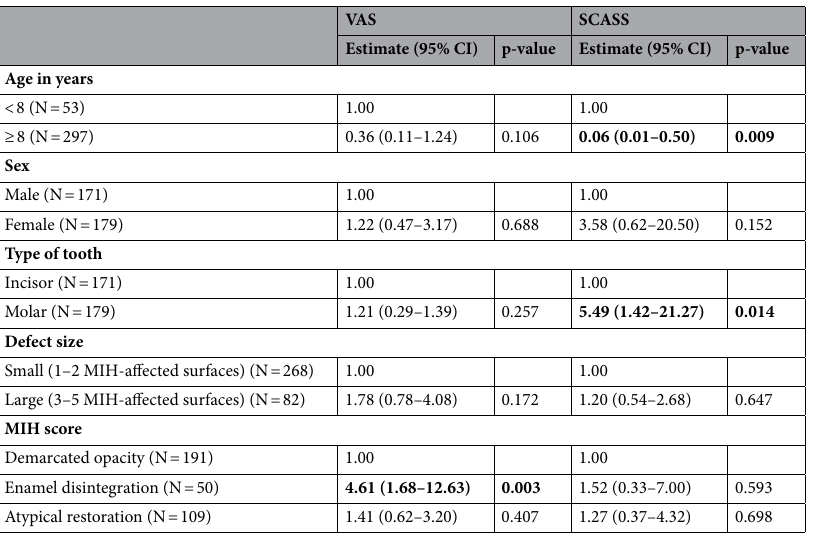
Table 3. Results from the mixed logistic regression model between hypersensitivity perceived by MIH patients (Visual Analogue Scale, range 0–10) and the dentist (Schiff Cold Air Sensitivity Scale, range 0–3) and potential influencing variables. Significant values are reported in bold